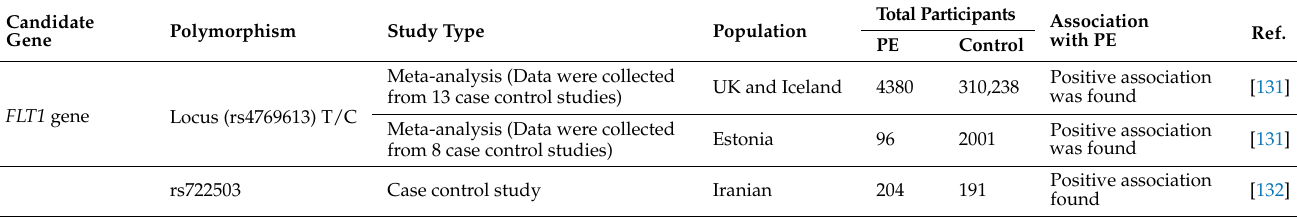
Table 2. Candidate genes associated with the pathogenesis of